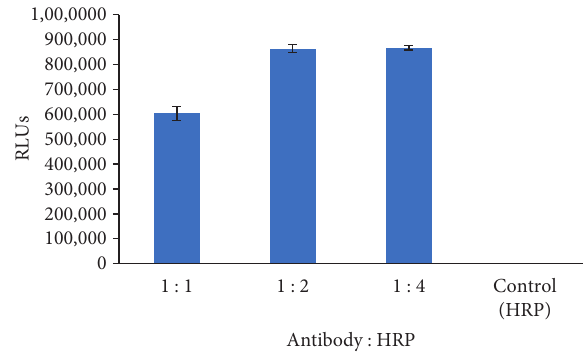
Figure 1: Characterisation of antibody-HRP conjugate ( n �